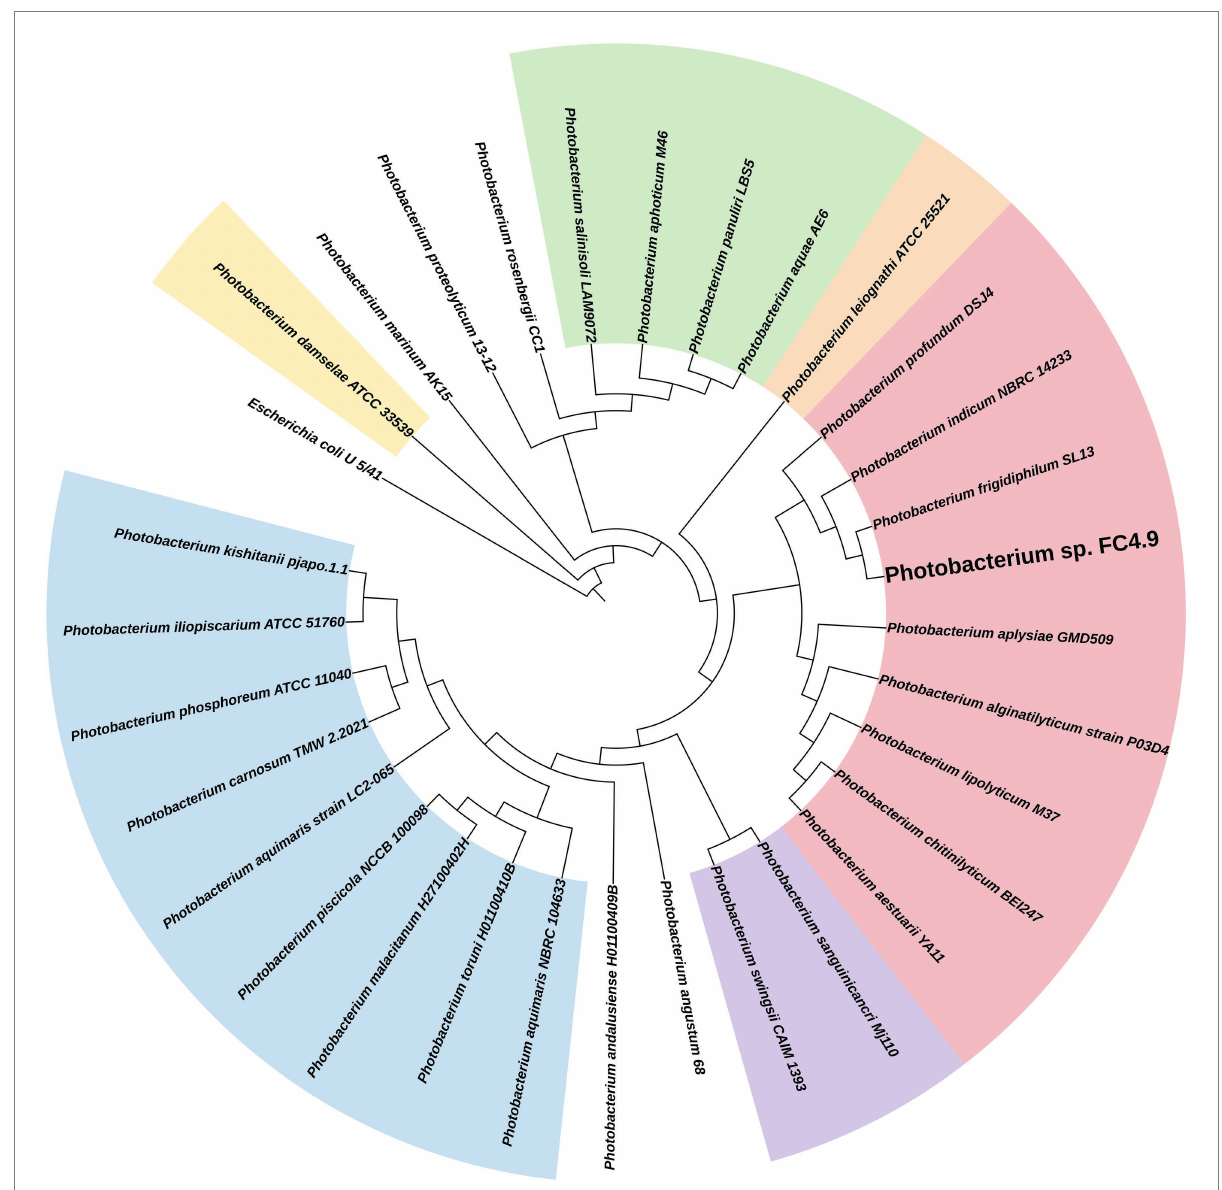
FIGURE 3 Phylogenetic tree generated from 16S rRNA gene sequence alignment. Within the Photobacterium genus, the propane producing strain Photobacterium sp. FC4.9 grouped to the Profundum clade. The phylogenetic tree was generated from an alignment of the 16S rRNA gene sequence from PCR amplified Photobacterium sp. FC4.9 DNA against the 16S rRNA gene sequences of the type strains of the 30 species within the